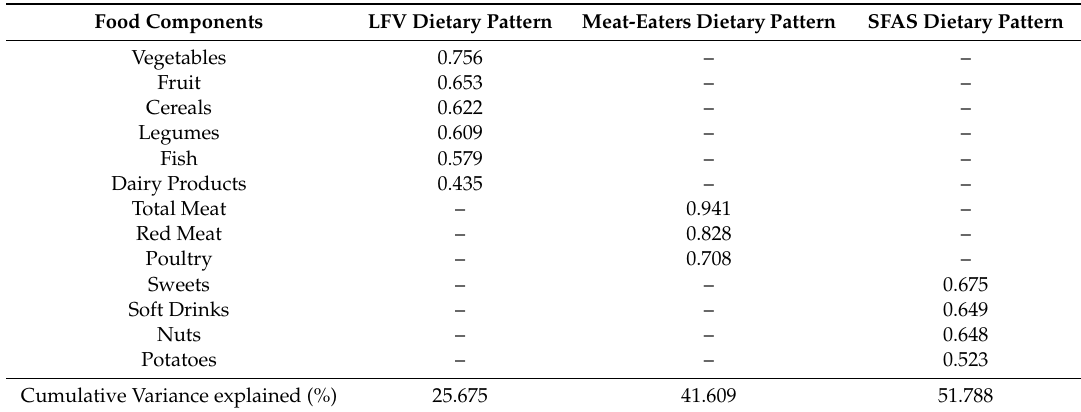
Table 1. Factor loadings of the food components included in the extracted dietary